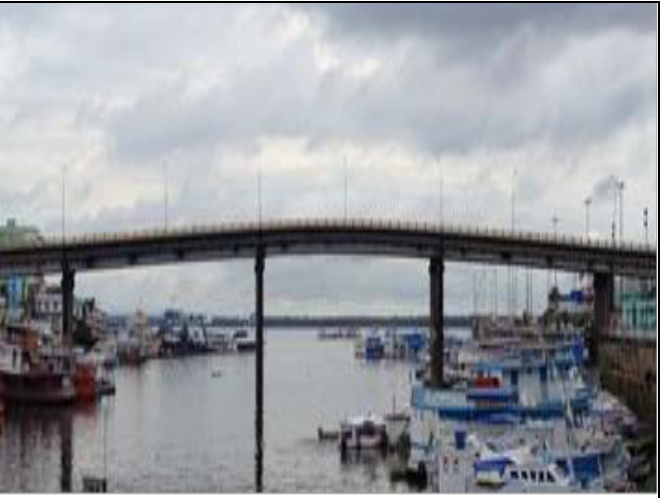
Figura 10: Igarapé do quarenta ponte do bairro do educandos. Fonte: Autores, (2018).